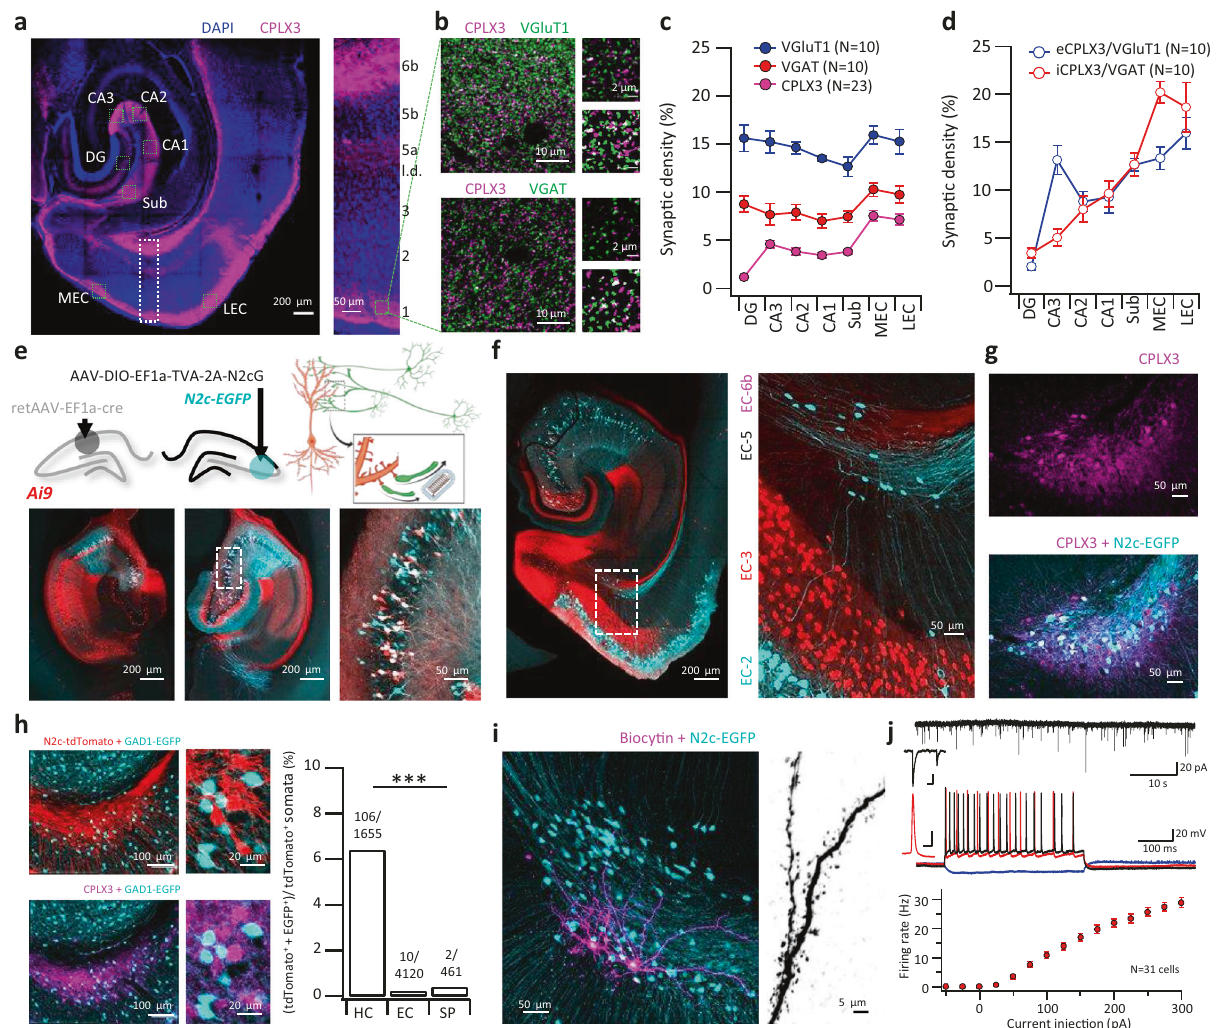
Fig. 1 | A direct excitatory projection from EC-6b to hippocampal CA3. a Representative horizontalsectionstained for CPLX3 and DAPI (left) alongsidean expanded view of the cortex (right). b Representative STED images from LEC-1, stained for CPLX3 alongside either VGluT1 (top left) or VGAT (bottom left). Expanded inserts are shown to the right of each image above their corresponding mask,demonstratingthecalculationofcolocalizationforeachmarker. c Analysisof synaptic density, using STED images acquired from the fi elds denoted by green dashedsquaresin(a).Synapticdensitywascalculatedhereastheratiobetweenthe signalareaandtotalimagearea. d RelativeeCPLX3andiCPLX3signaldensityofthe total VGluT1 or VGAT signal area. e Unilateral injection of retAAV into the CA1 enables genetic targeting of the contralateral CA3 for retrograde labeling, exploiting the abundance of commissural axons of CA3 pyramidal neurons (top schematics).Representativehorizontalsectionsfromthemid-dorsalhippocampus of the ipsilateral (bottom left) and contralateral (bottom center) hemispheres for RetAAV-cre injection. Double-labeled neurons in the enlarged inset (bottom right) are putative starter cells. f , g Representative horizontal section from the ventral hippocampus following CA3-speci fi c retrograde labeling reveals a population of